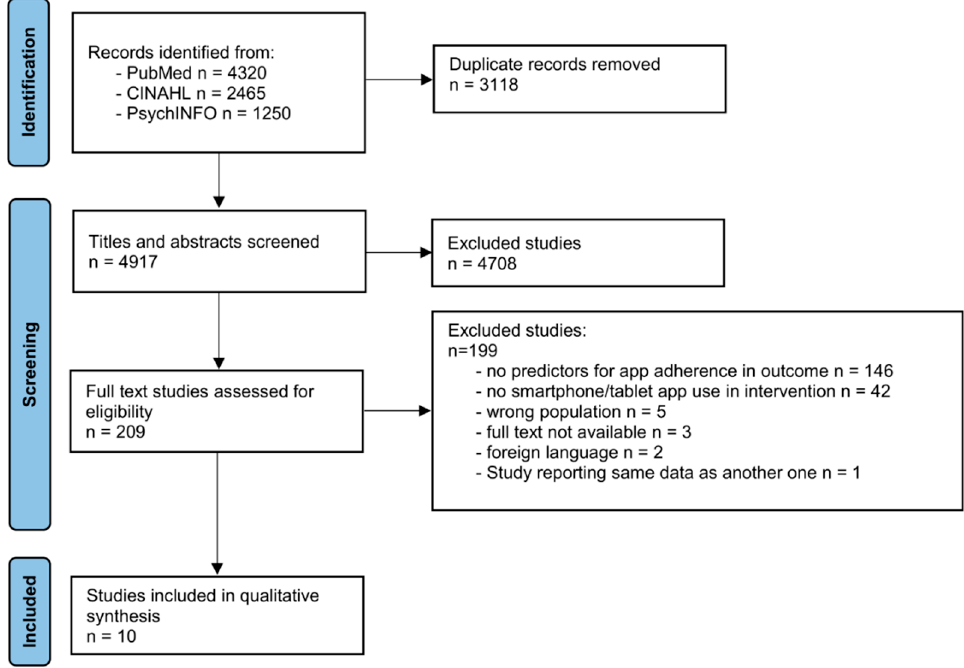
Figure 1. PRISMA flowchart.